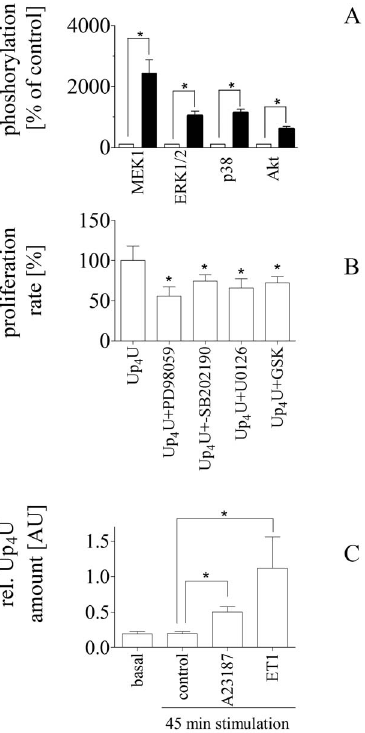
Figure 4. ( A )Effect of Up 4 U on phosphorylation of MAPK. Phosphor- ylation of MEK1, ERK1/2, Akt, and p38 measured by Luminex TM technique before (open bar) and after stimulation with Up 4 U for 10 min (filled bar). Ratio of phospho/total were normalized to protein content of the lysates and demonstrated as percent stimulation relative to control (*p , 0.05; n=5). ( B )Effect of PD98059, U0126, SB2021902, and GSK on Up 4 U induced proliferation rate in vascular smooth muscle cells ( C )Up 4 U amount of secretome from in-vivo/ex-vivo stimulated aortic rings. (*p , 0.05; n=4).